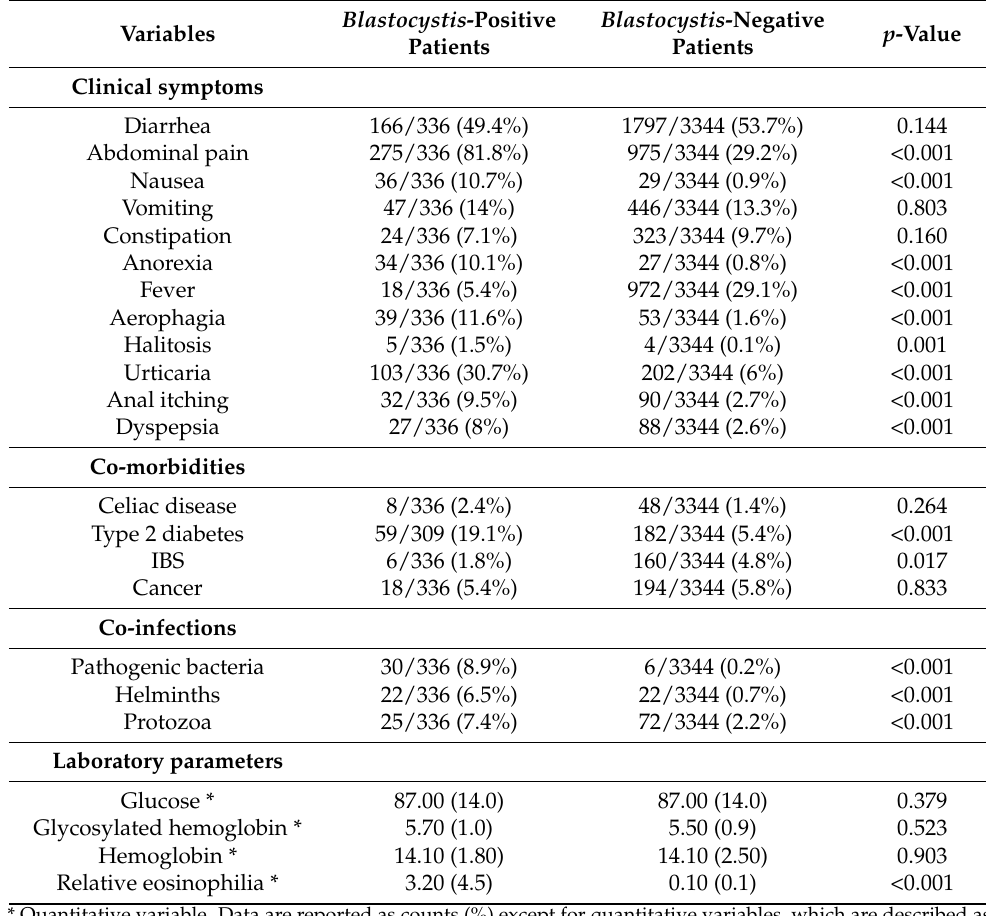
Table 2. Clinical symptoms, co-morbidities, co-infections, and hematological/biochemical parameters in cases ( Blastocystis -positive patients) and in controls ( Blastocystis -negative